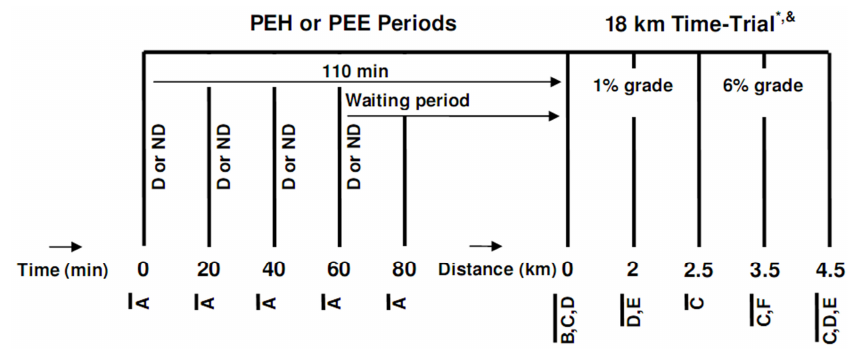
Figure 1. Schematic representation of the research protocol. (D or ND) Drink or no drink; ( A ) Measurement of urine volume, urine specific gravity, bodyweight, heart rate, perceived thirst, abdominal bloating and pain, nausea and dizziness; ( B ) Measurement of urine volume, urine specific gravity and bodyweight; ( C ) Measurement of rectal temperature, skin temperature and heart rate; ( D ) Measurement of perceived exertion, perceived thirst, perceived heat stress and abdominal discomfort; ( E ) Consumption of 1 mL/kg bodyweight of sports drink; ( F ) Measurement of perceived exertion and perceived thirst; PEH: Pre-exercise hyperhydration; PEE: Pre-exercise euhydration; * this 4.5 km block was repeated four times; & after running 9 km, subjects stopped for measurement of urine volume, urine specific gravity and bodyweight and to consume one sports